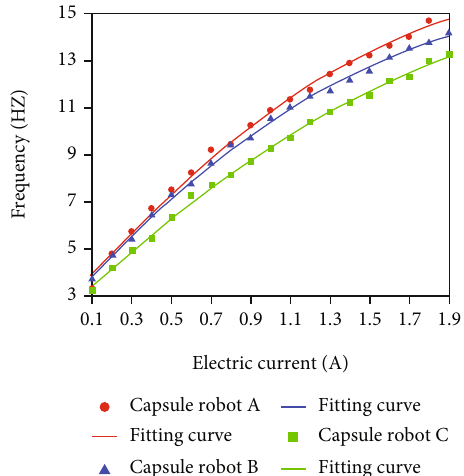
Figure 9: Start-up frequency at di ff erent current currents.